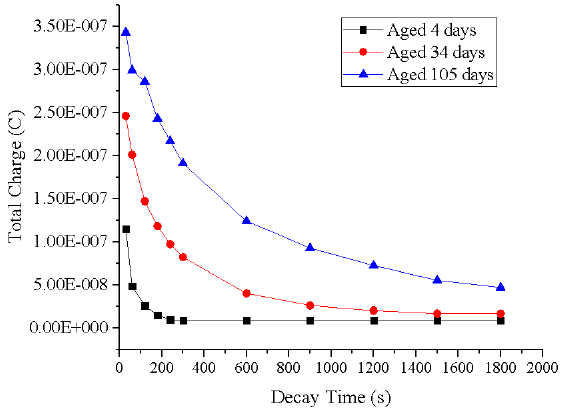
Figure 11. Total charge amount inside oil ‐ paper with different ageing degrees.